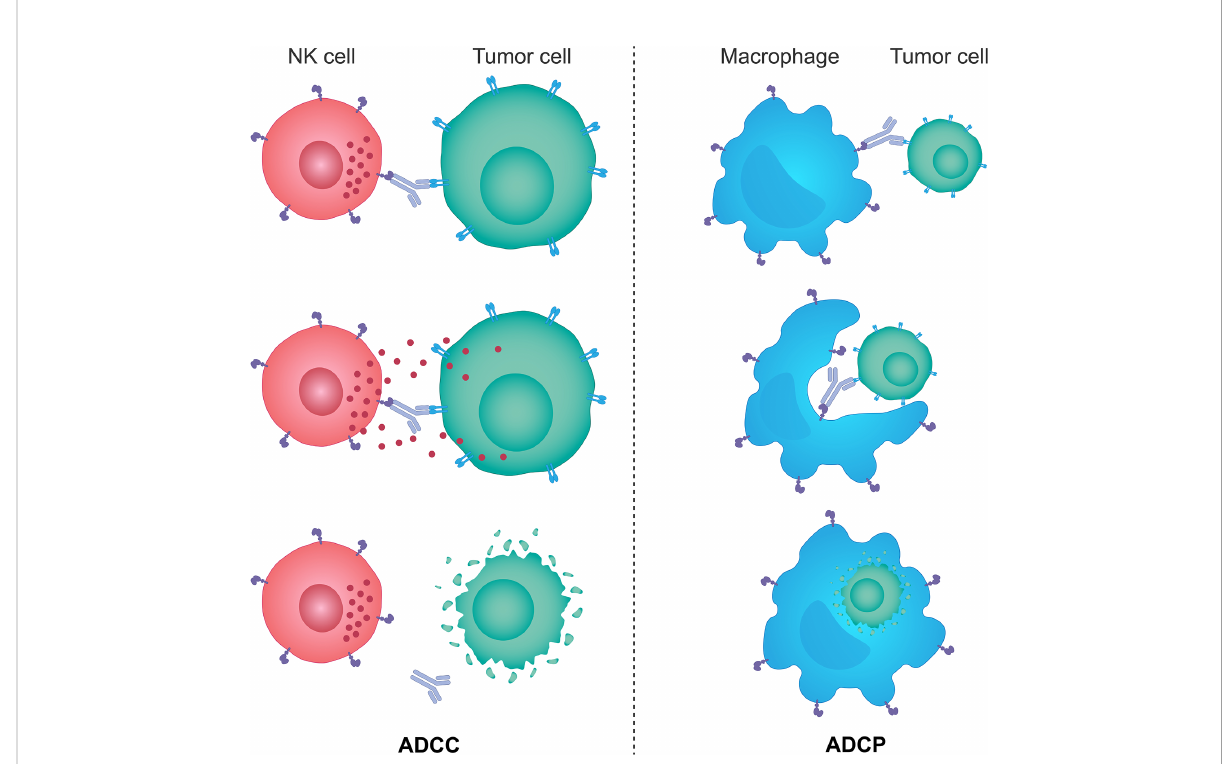
FIGURE 2 The mechanisms of ADCC and ADCP response. Monoclonal therapeutic antibodies designed to target speci fi c tumor cell antigens can also use their Fc portion of the immunoglobulin to anchor NK cells and macrophages through speci fi c Fc receptors expressed on the surface of these cells. Such interactions trigger activating signals downstream of Fc receptors in NK cells and macrophages and lead to NK cell-mediated ADCC and macrophage-mediated ADCP responses. NK cells brought in the vicinity of target tumor cells by monoclonal antibodies kill those cells predominantly through the perforin/granzyme cell death pathway, while activated macrophages engulf antibody-opsonized target tumor cells and degrade them through acidi fi cation of the phagosome. ADCC, antibody-dependent cellular cytotoxicity; ADCP, antibody-dependent cellular phagocytosis; Fc, fragment crystallizable; NK, natural